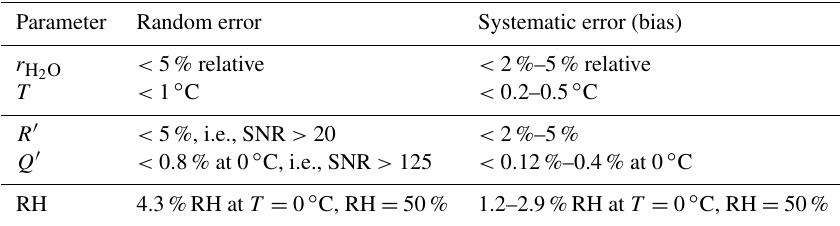
Table 1. Summary of accuracy requirements from Wulfmeyer et al. (2015) and corresponding constraints on ratios R (cid:48) and Q (cid:48) . Resulting errors on relative humidity RH at 0 ◦ C and